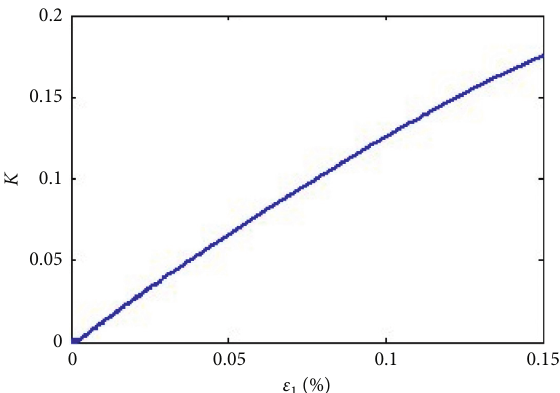
Figure 11: Curves of K ∼ ε 1 of sandstone under axial unloading and radial unloading paths.